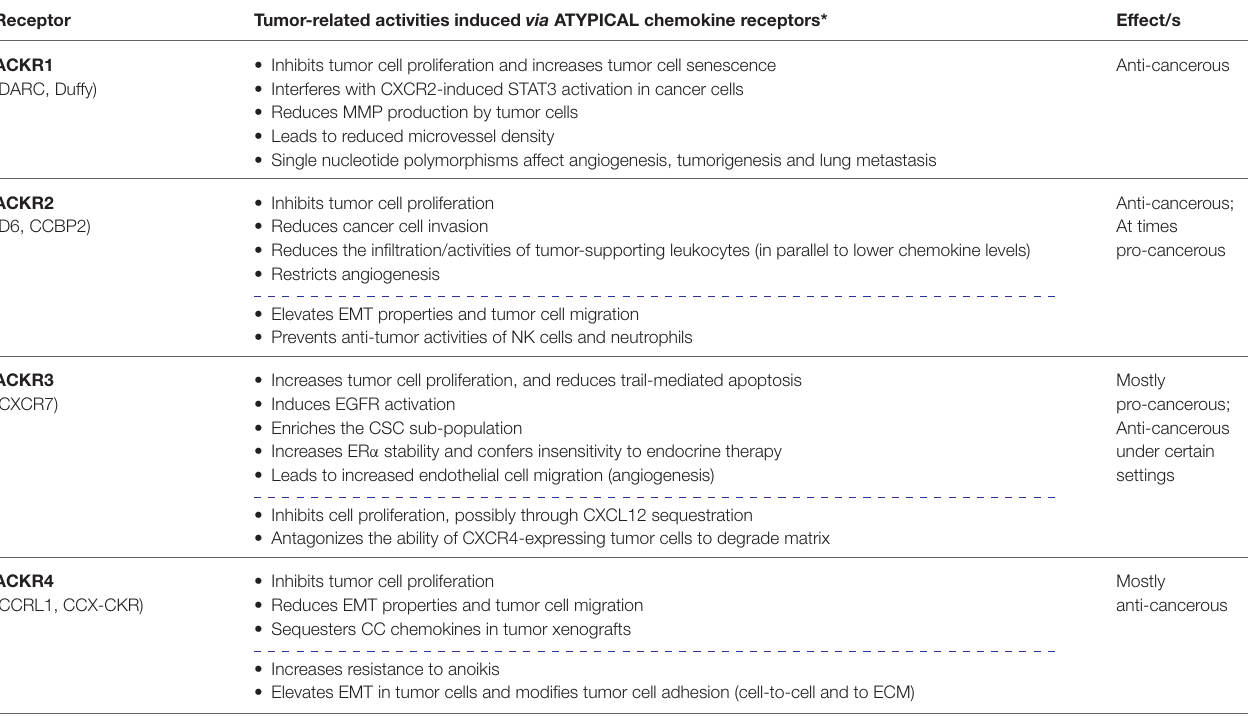
TABLE 2 | Tumor-related activities, mediated by atypical chemokine receptors. Receptor Tumor-related activities induced via ATYPICAL chemokine receptors* Effect/s ACKR1 (DARC,